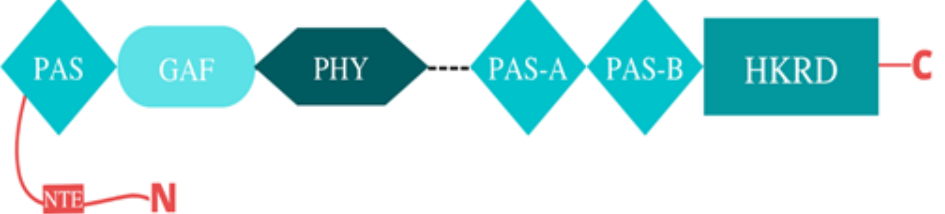
Figure 2. Structure of plant phytochrome. The photosensory module (PSM) of the phytochrome is predominantly made up of the conserved domains PAS, GAF, and PHY, which are responsible for photosensory activity and bilin molecule binding. The PAS and GAF domains of the photosensory core (the N-terminus) are knotted together. The PHY domain is responsible for stabilizing the Pfr chromophore. The distant end of the protein (i.e., the C-terminus), also called the output module (OPM), is made up of two domains: the PAS-A and PAS-B sub-domains (together called the PRD – PAS repeat domain), as well as the histidine kinase-related domain (HKRD), and it is responsible for dimerization. The PAS-A and PAS-B sub-domains are only found in plant phytochromes, and they form the PAS-repeat domain (PRD), whereas the HKRD domain is also found in phytochrome- like proteins.